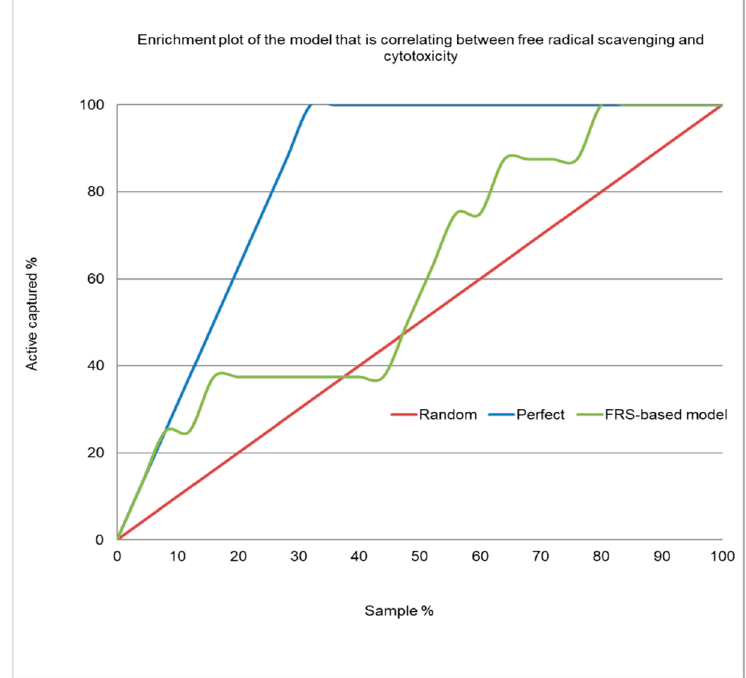
Figure 3. Enrichment plot of the prediction model for the antibacterial activity of the plant extracts, based on their free radical scavenging activity (non-polar extracts).